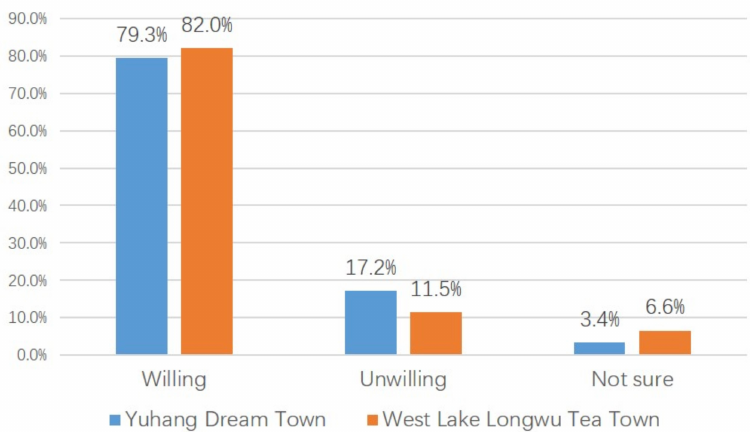
Figure 24. Proportion of respondents willing to participate in discussion activities on the planning and construction of the local CT practice (source: